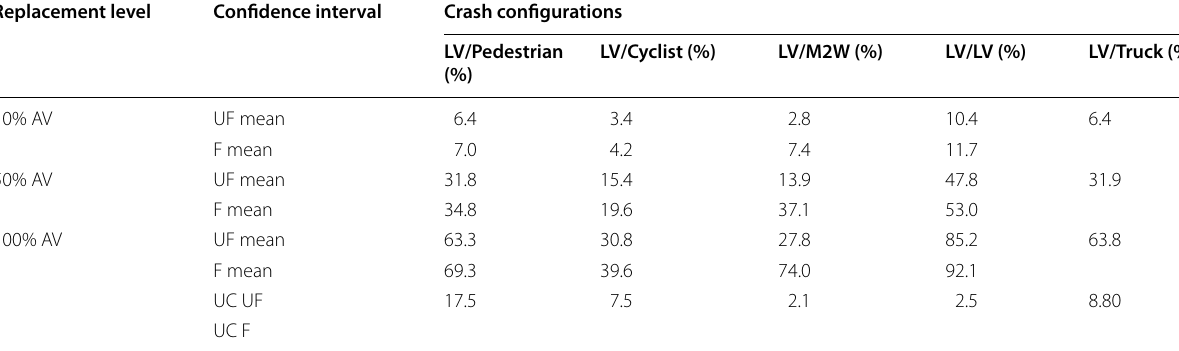
AV, Autonomous Vehicle; LV, Light Vehicle; M2W, Motorized-Two-Wheeler; UF, Unfavourable; F, Favourable; (here results are the same for F and UF); UC, Uncovered *% on 100% fatal crashes within each configuration